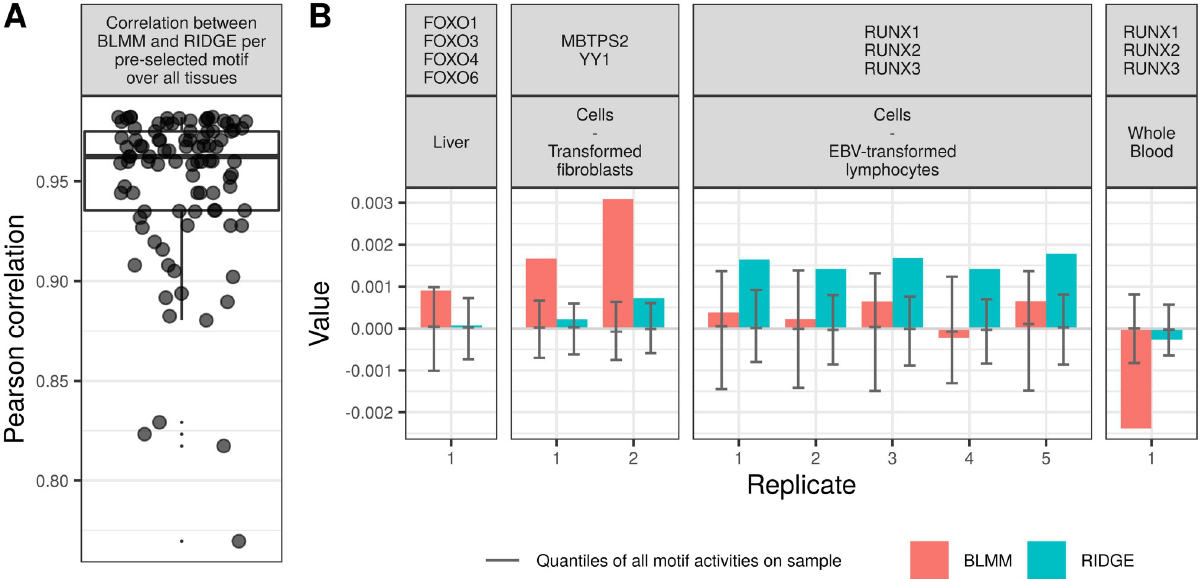
Fig 5. IQR-study on GTEx motif-weight. (A): Pearson correlation values between the predicted posterior motif influence ^ o Linear Mixed Model and the Ridge Regression of 56 selected motif values over all tissues. (B): extreme cases of different motif scores per method. Each box shows the predicted motif scores per sample, separated by model assumptions used to predict the scores (dependence, denoted BLMM, colored in red, and indepdence between samples, named RIDGE, colored in blue). Per sample, the first, second and third quantile (as in a boxplot) of the overall motif activity of all motifs on that sample are depicted in